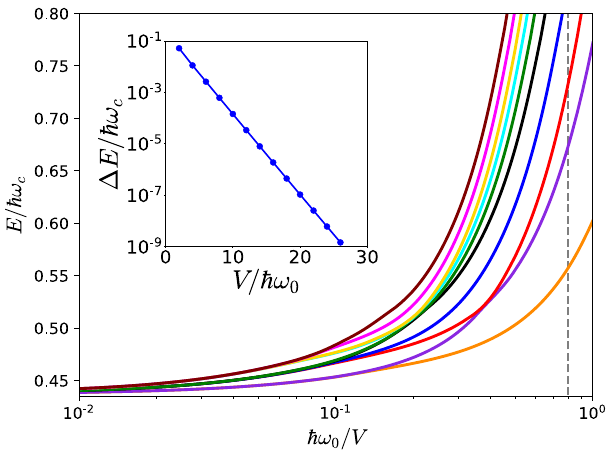
FIG. 5. Expectation value of the LLL projector in the ground state of the Hamiltonian in Eq. (28) for different values of V= ℏ ω as function of V= ℏ ω 0 . As expected, the LLL projection c becomes more accurate for smaller values of the energy ratios V= ℏ ω and ℏ ω 0 =V . We mark with a green circle the values of c 0 . 4 and ℏ ω 0 . 8 that are experimentally rel- V= ℏ ω 0 =V ¼ c ¼ evant for our circuit proposal; see Sec. VI. For these values, ψ 0 . 981 we find h ψ 0 j Π 0 i ¼ LLL j